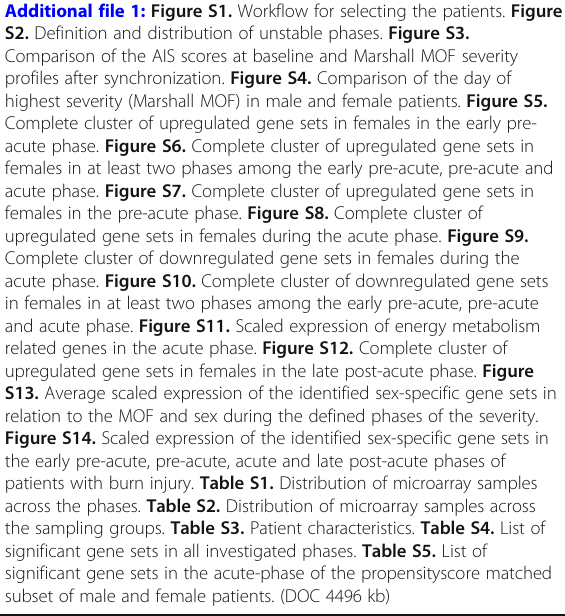
Additional file 1: Figure S1. Workflow for selecting the patients. Figure S2. Definition and distribution of unstable phases. Figure S3. Comparison of the AIS scores at baseline and Marshall MOF severity profiles after synchronization. Figure S4. Comparison of the day of highest severity (Marshall MOF) in male and female patients. Figure S5. Complete cluster of upregulated gene sets in females in the early pre- acute phase. Figure S6. Complete cluster of upregulated gene sets in females in at least two phases among the early pre-acute, pre-acute and acute phase. Figure S7. Complete cluster of upregulated gene sets in females in the pre-acute phase. Figure S8. Complete cluster of upregulated gene sets in females during the acute phase. Figure S9. Complete cluster of downregulated gene sets in females during the acute phase. Figure S10. Complete cluster of downregulated gene sets in females in at least two phases among the early pre-acute, pre-acute and acute phase. Figure S11. Scaled expression of energy metabolism related genes in the acute phase. Figure S12. Complete cluster of upregulated gene sets in females in the late post-acute phase. Figure S13. Average scaled expression of the identified sex-specific gene sets in relation to the MOF and sex during the defined phases of the severity. Figure S14. Scaled expression of the identified sex-specific gene sets in the early pre-acute, pre-acute, acute and late post-acute phases of patients with burn injury. Table S1. Distribution of microarray samples across the phases. Table S2. Distribution of microarray samples across the sampling groups. Table S3. Patient characteristics. Table S4. List of significant gene sets in all investigated phases. Table S5. List of significant gene sets in the acute-phase of the propensityscore matched subset of male and female patients. (DOC 4496